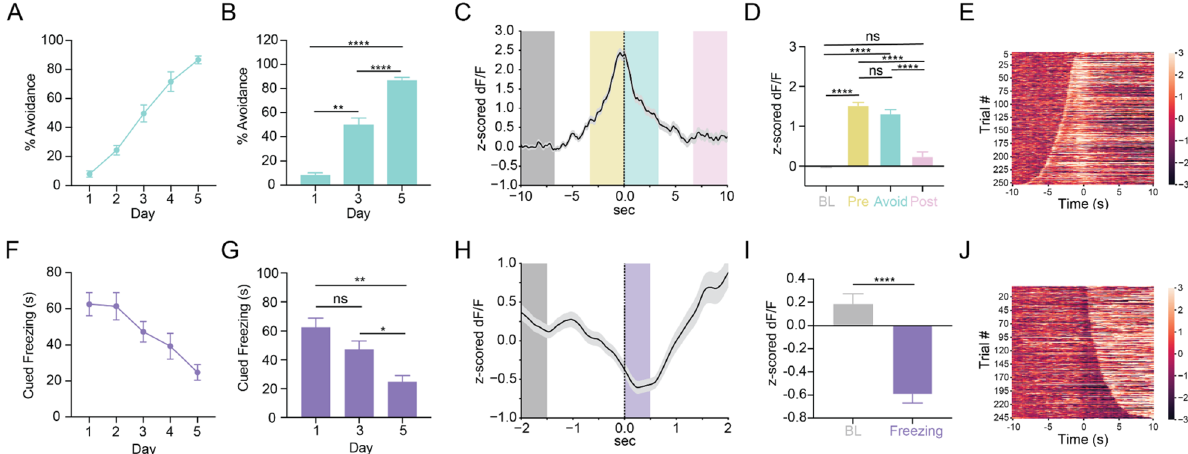
Figure 2. dmPFC shows opposing patterns of activity during active avoidance and cued freezing behavior. ( A ) Percent successful avoidance across training days. Learning curve displays the same data as seen in Fig. 1C. ( B ) Quantification of percent successful avoidance shows animals significantly increase avoidance across training. ( C ) PETH shows an increase in calcium signal at avoidance onset on Day 5. Line with shading represents mean ± SEM. Grey box, baseline period (BL); yellow box, pre-avoidance period (Pre); teal box, avoidance period (Avoid); pink box, post-avoidance period (Post). ( D ) Quantification of avoidance PETH reveals significantly increased calcium signal in the pre-avoid (−3 to 0 s) and avoid (0 to 3 s) periods but not the post-avoid period (7 to 10 s) compared to the baseline period (−10 to −7 s). ( E ) Heatmap of change in calcium signal for all avoidance trials for all mice from Day 5 aligned to avoidance onset and sorted from shortest to longest avoidance latency. Heatmap shows distinct increases in calcium signal at CS onset (slope curving leftward) and avoidance onset (time zero). ( F ) Cued freezing during the CS-only period across training days. ( G ) Quantification of cued freezing shows that animals significantly decrease cued freezing across training. ( H ) PETH shows decrease in calcium signal at freezing onset on Day 1. Line with shading represents mean ± SEM. Grey box, baseline period (BL); Purple box, freezing period (Freezing). ( I ) Quantification of freezing PETH shows significant decrease in calcium signal during the freezing period (0–0.5 s) compared to the baseline period (−2 to −1.5 s). ( J ) Heatmap of change in calcium signal during all individual freezing bouts from all mice from Day 1 aligned to freezing onset and sorted from shortest to longest freezing bout. Heatmap shows dips in calcium signal at freezing onset that increases in length as freezing bout duration increases. ns = not significant, * p < 0.05, ** p < 0.01, **** p <